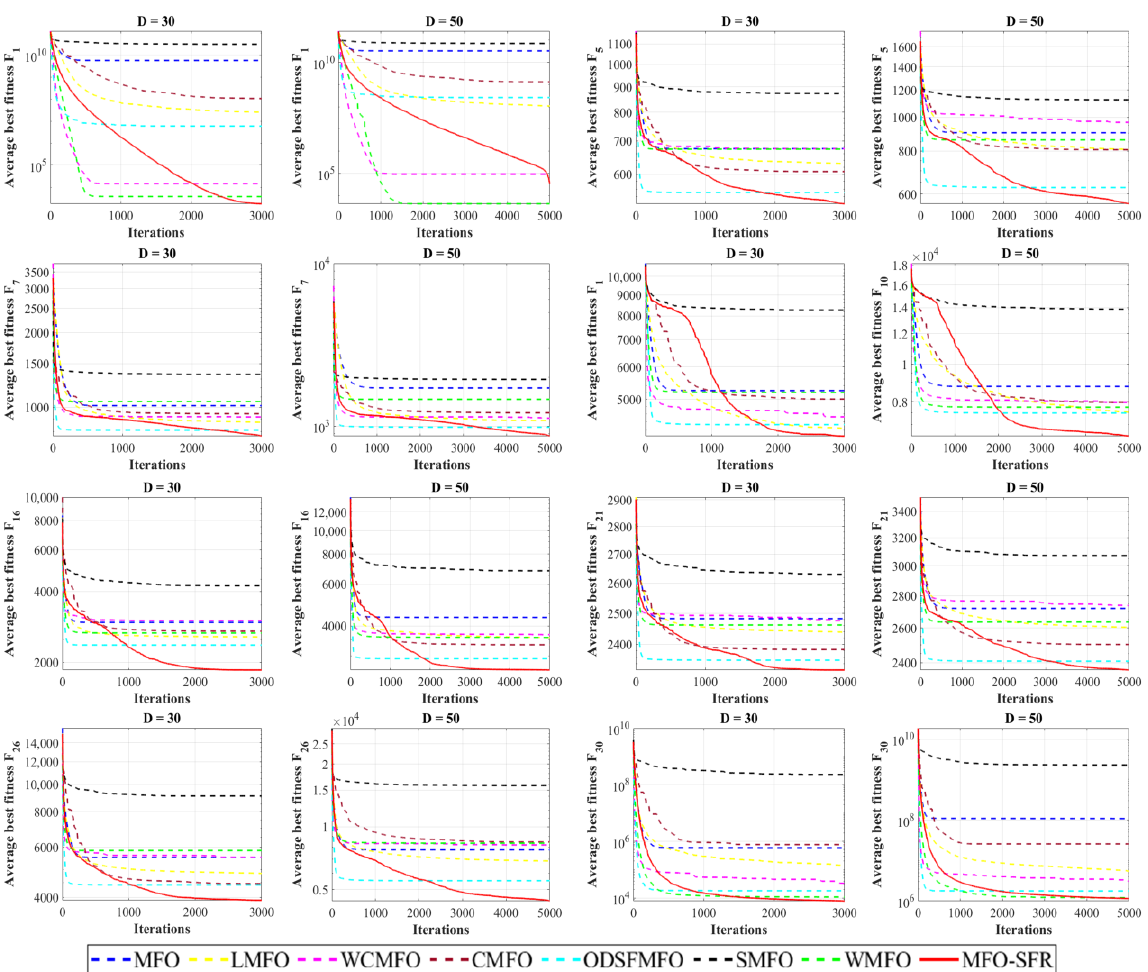
Figure 2. Convergence comparison of MFO-SFR, MFO, and its variants on CEC 2018 with D = 30 and 50.